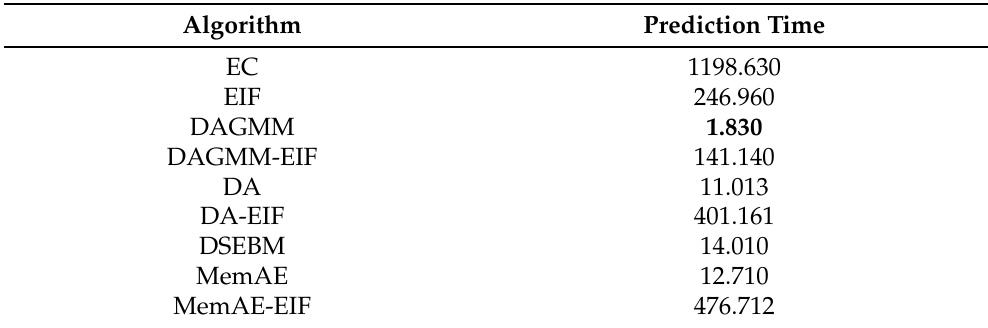
Table 4. Prediction times for analyzing 1000 records of the NSL-KDD dataset. The times shown in the table are measured in milliseconds.